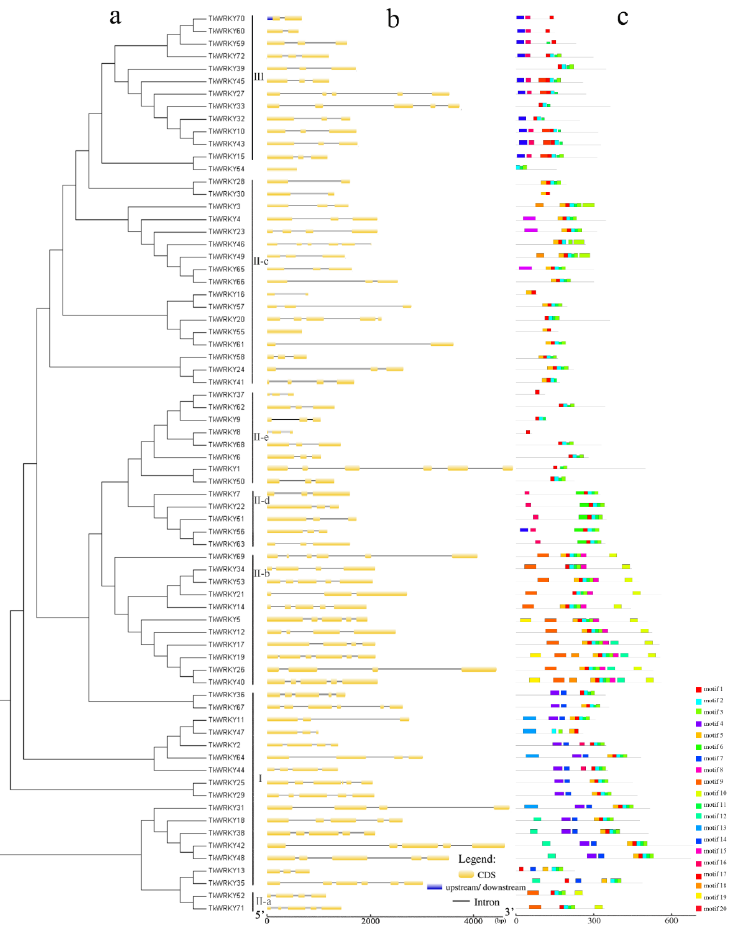
Figure 4. Phylogeny ( a ), gene structure ( b ), and putative motif analysis ( c ) of each TkWRKY gene and WRKY protein. Exons, introns, and upstream/downstream are represented by yellow, black, and blue lines, respectively. The length and proportion are measured with a ruler below. The length and position of the 20 motifs are represented by differently colored boxes. The WRKY III gene in plants originated after the differentiation of monocots and di- cots, and it seemed to play a critical role in plant adaptation and evolution [38]. To study the evolution of the TKS Group III WRKY gene, MEGA7 was used to construct four mon- ocotyledonous plants (rice, maize, Brachypodium distachyon , and pineapple) and five dicot- yledonous plants ( Arabidopsis , grapes, peaches, poplars, and Taraxacum kok-saghyz Rodin) of Group III WRKY protein phylogenetic trees. All the WRKY family members of Group III was divided into 8 clades (Figure 5). The species that aggregated in the same clade were closely related. Most proteins in dicotyledons were clustered on Clade 1, 4, and 7, whereas most proteins in monocotyledons were clustered on Clade 1, 2, 3, 5, 6, and 8, which strongly indicated that the evolutionary relationships among the WRKY members of the